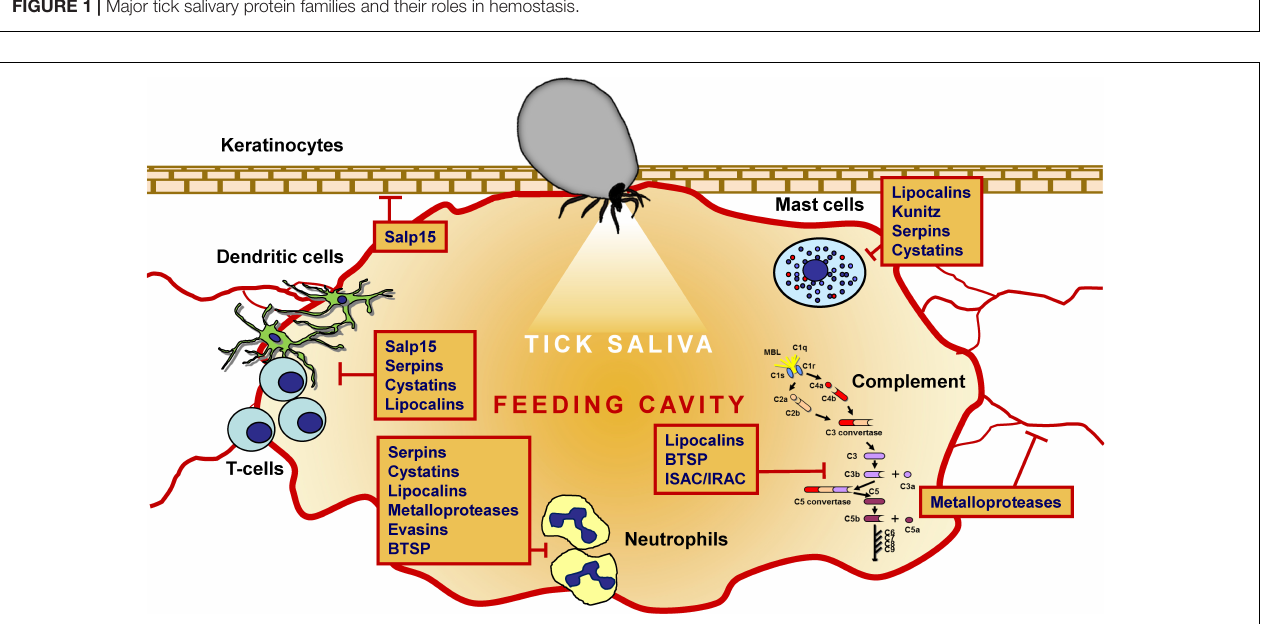
FIGURE 2 | The immunomodulatory and anti-complement activities of the major tick-secreted protein